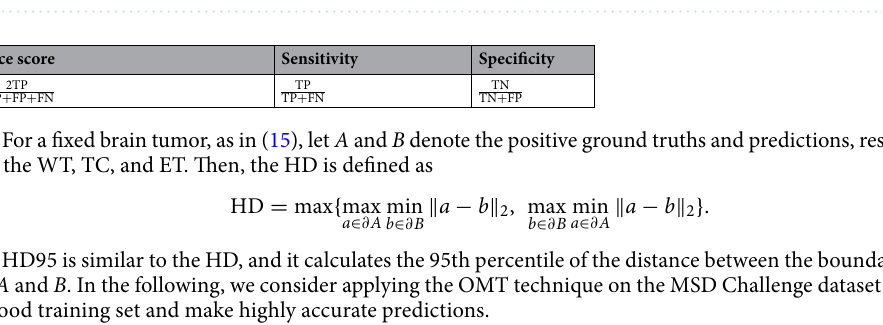
Figure 6. The Dice scores for training and testing (blue lines) and the loss functions for training and validation (red lines) vs. the number of epochs for the WT, TC, and